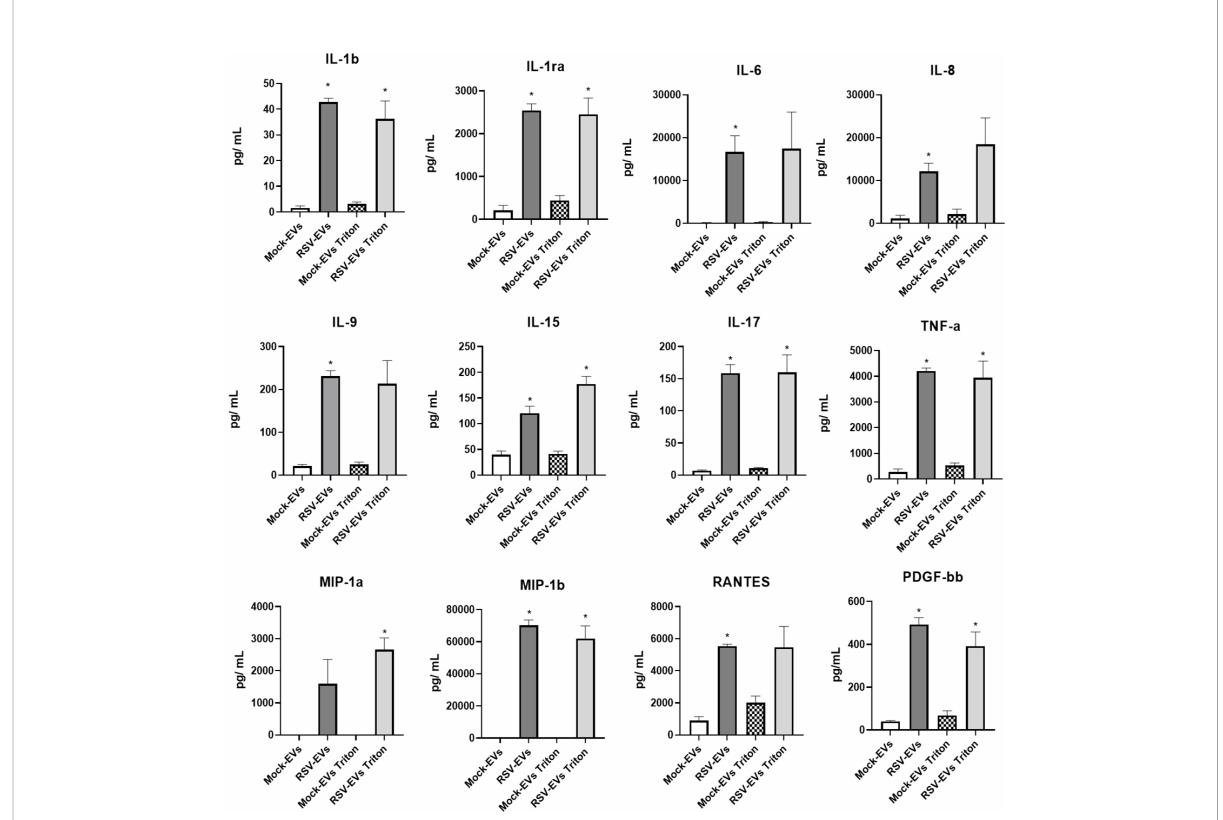
FIGURE 1 Cytokine concentrations associated with EVs released from mock- and RSV-infected A549 cells. Cytokines were measured using a human multi-plex panel array as intact or Triton lysed EVs. Data are presented as mean ± SEM. * indicates a statistical difference comparing RSV- EVs or RSV-Triton versus Mock-EVs or Mock-Triton, respectively (*p value < 0.05). Data represents the average of three independent